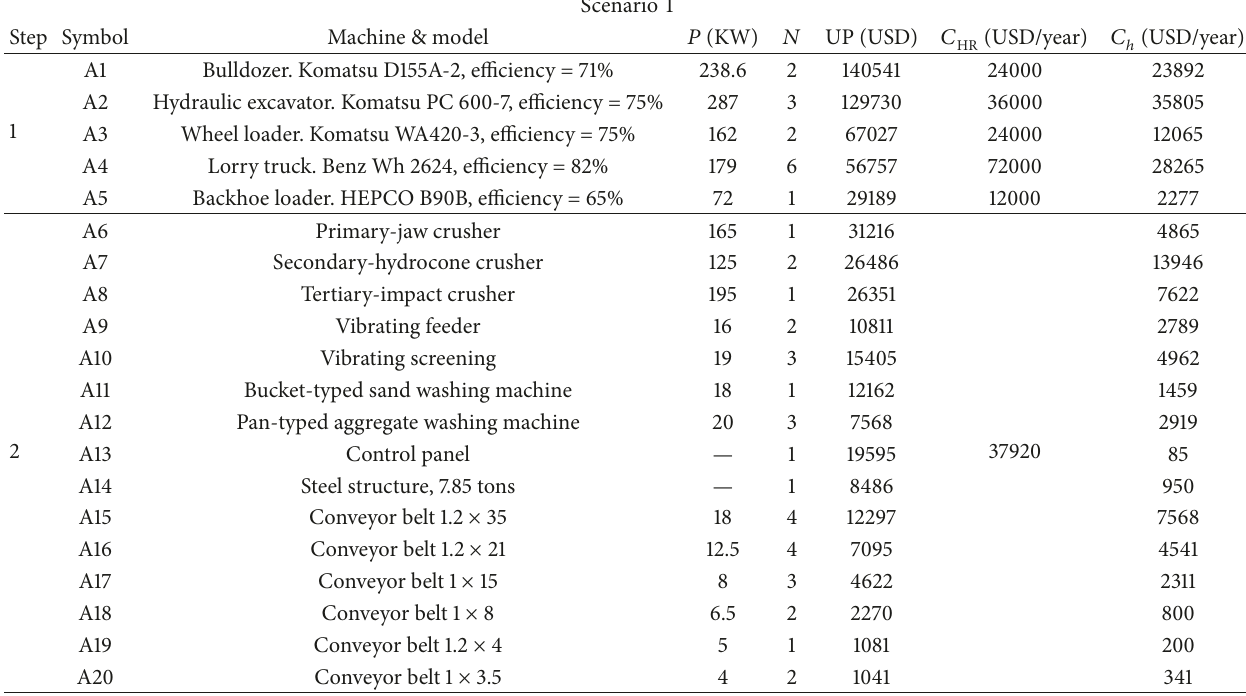
Table 3: The specifications of machinery in the production plant.